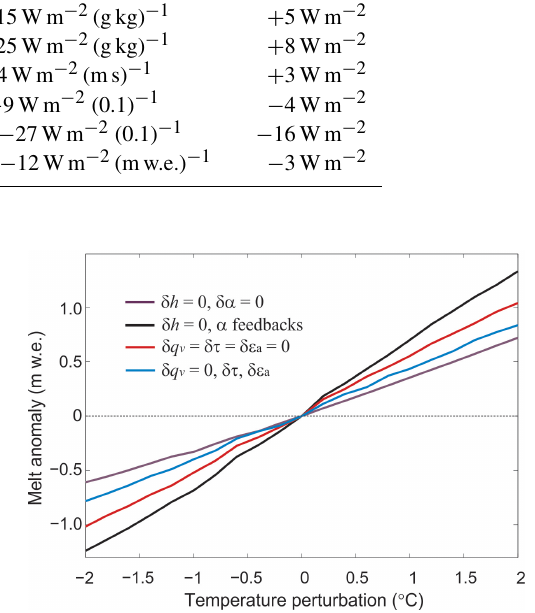
Figure 5. Sensitivity of modelled summer (JJA) melt to temper- ature perturbations for different assumptions, as per Table 4. The reference (mean 2002–2012) JJA melt is